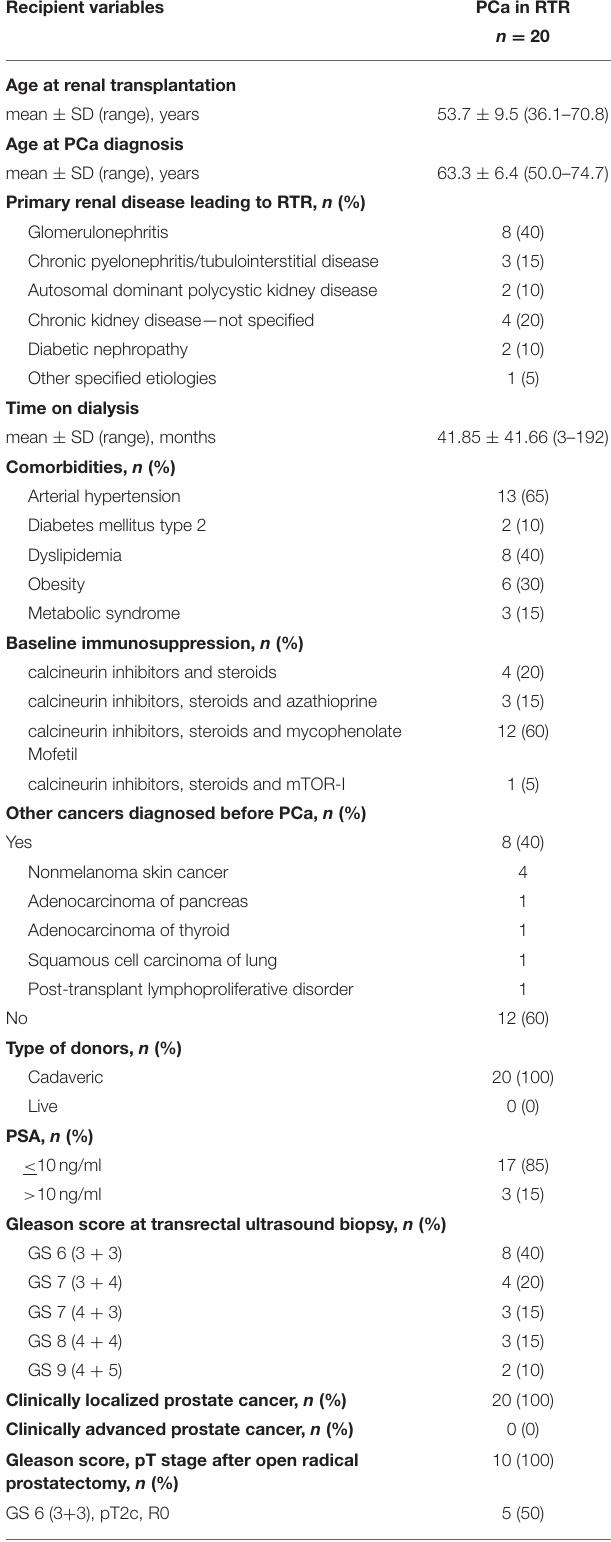
TABLE 1 | Characteristics of the study